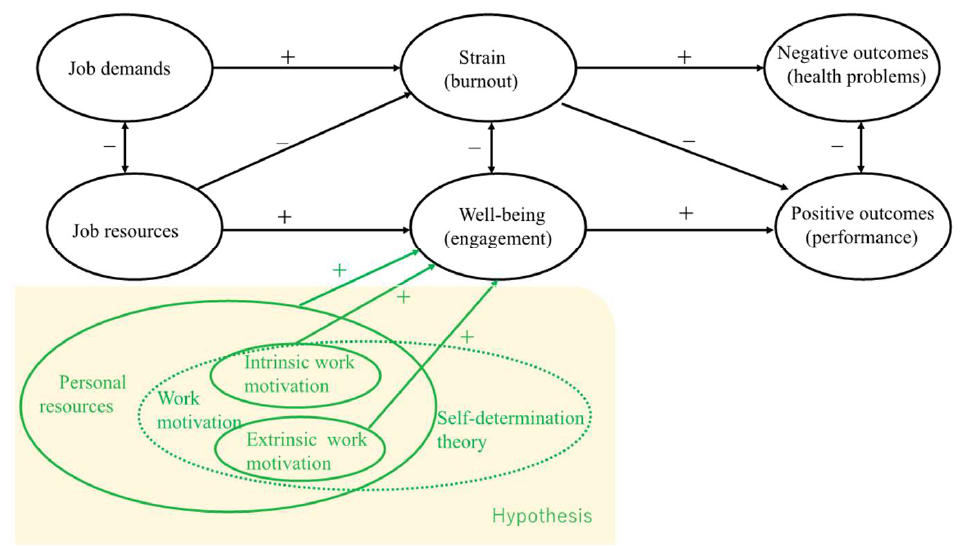
Figure 1. The theoretical model.